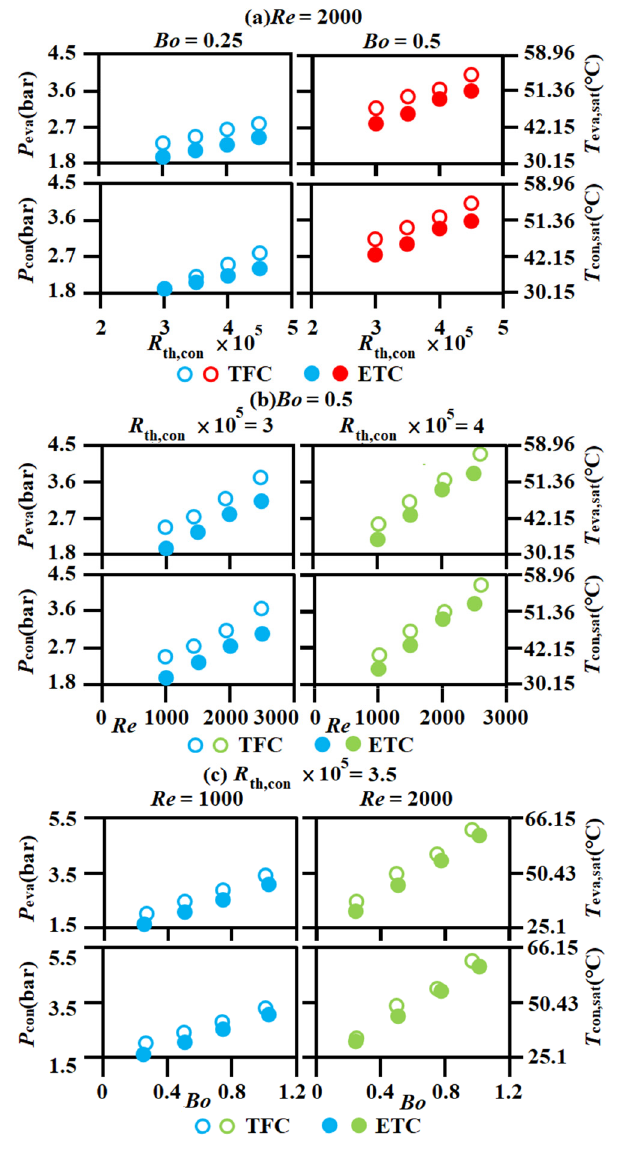
Figure 2. Variations of P eva,con and T eva,con, sat against ( a ) R th ,con at Re = 2000 ( b ) Re at Bo = 0.5. ( c ) Bo at R th ,con = 3.5 × 10 − 5 for the thermosyphon loops with TFC and ETC.